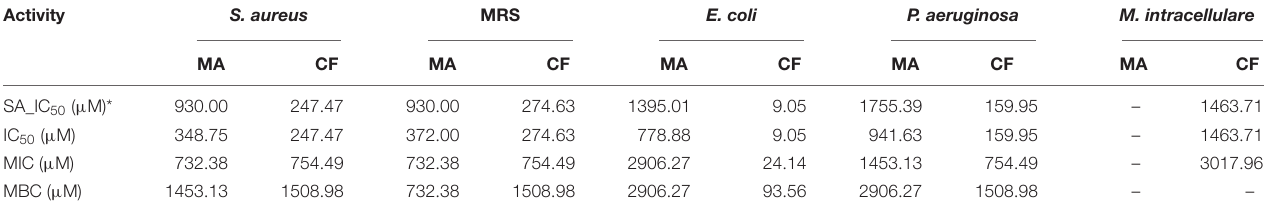
TABLE 3 | Antibacterial activity of monanchocidin A in µ M. Activity